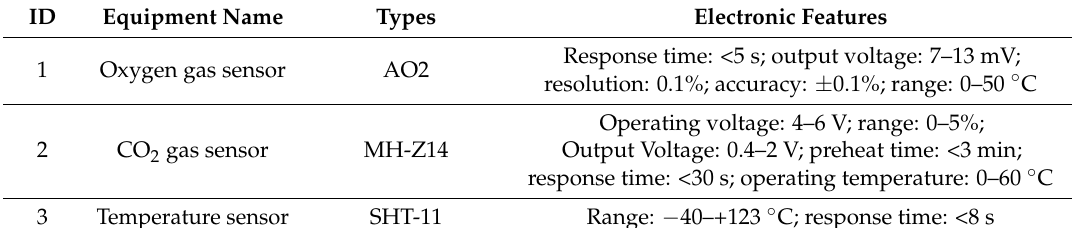
Figure 5. Hardware components for ambient data collection. Table 1. The sensors for monitoring in flatfish waterless transportation.